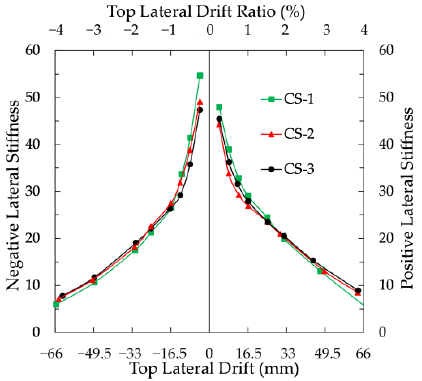
Figure 17. Stiffness degradation curves of subassemblies (unit: kN/mm).